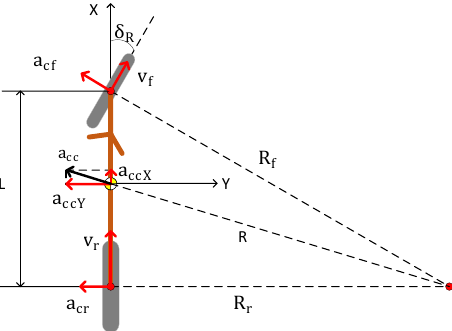
Figure 4. Top view of the two-wheeled motorcycle equipped with SGCMG.